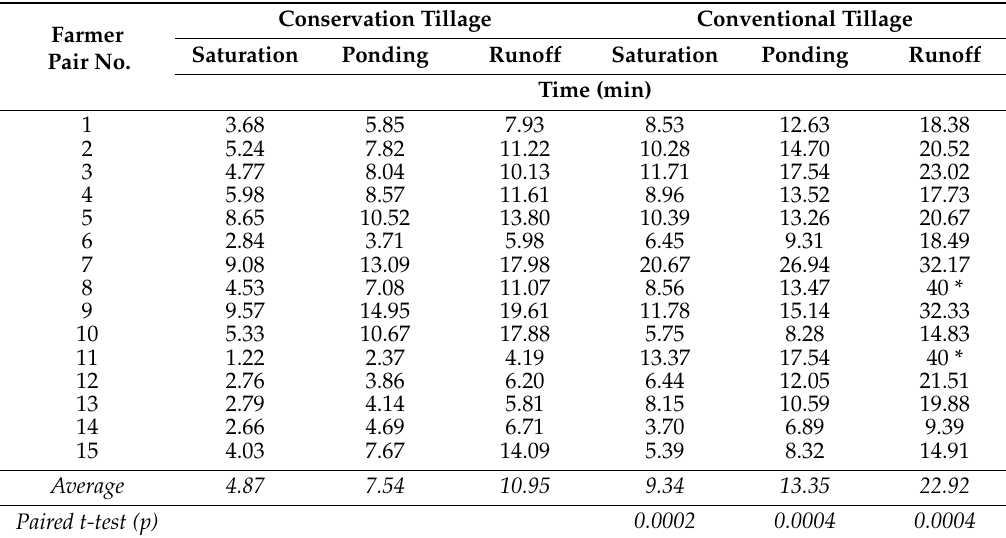
Table 3. Time for surface saturation, ponding, and initial runoff (according to pre ‐ defined criteria) for soils under conservation tillage and conventional tillage.